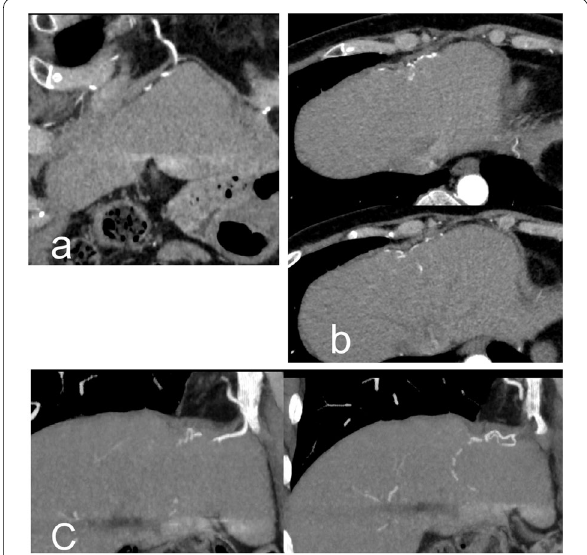
Fig. 3 The right internal thoracic artery was connected to the intrahepatic artery through Sappey’s superior artery on the coronal ( a ), axial ( b ), and oblique ( c ) post-ET CTA images in case